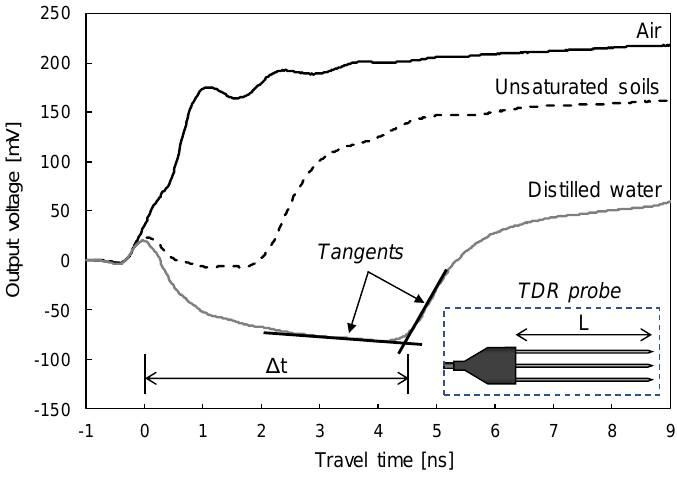
Figure 2. Typical TDR signals.